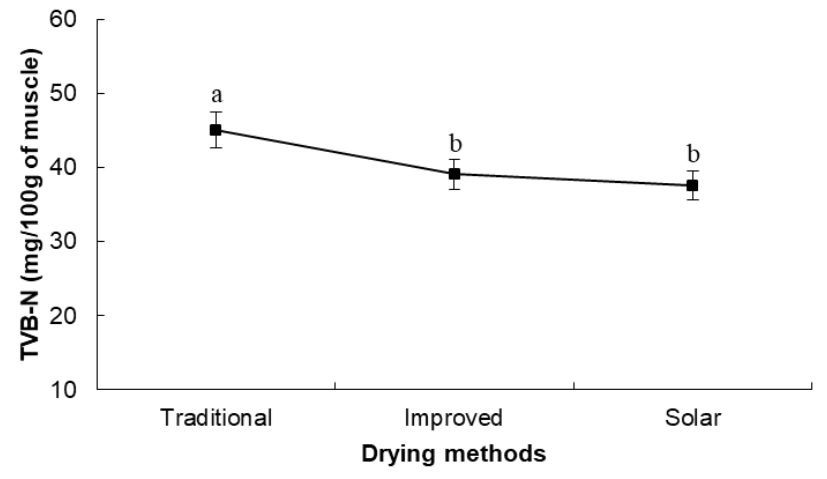
Figure 3. Total volatile base nitrogen (TVB-N) of H. molitrix in different drying methods.